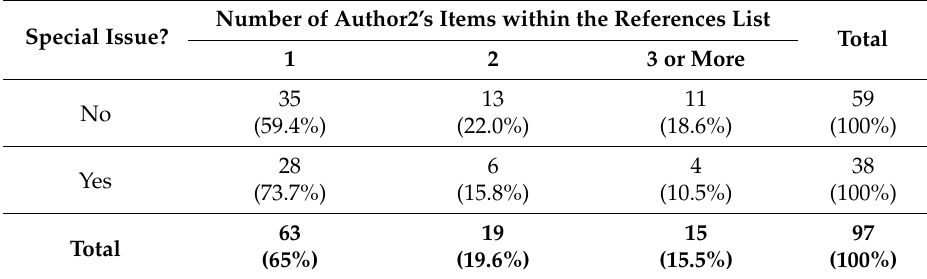
Table 5. Number of Author2’s paper citations according to the journal’s issue